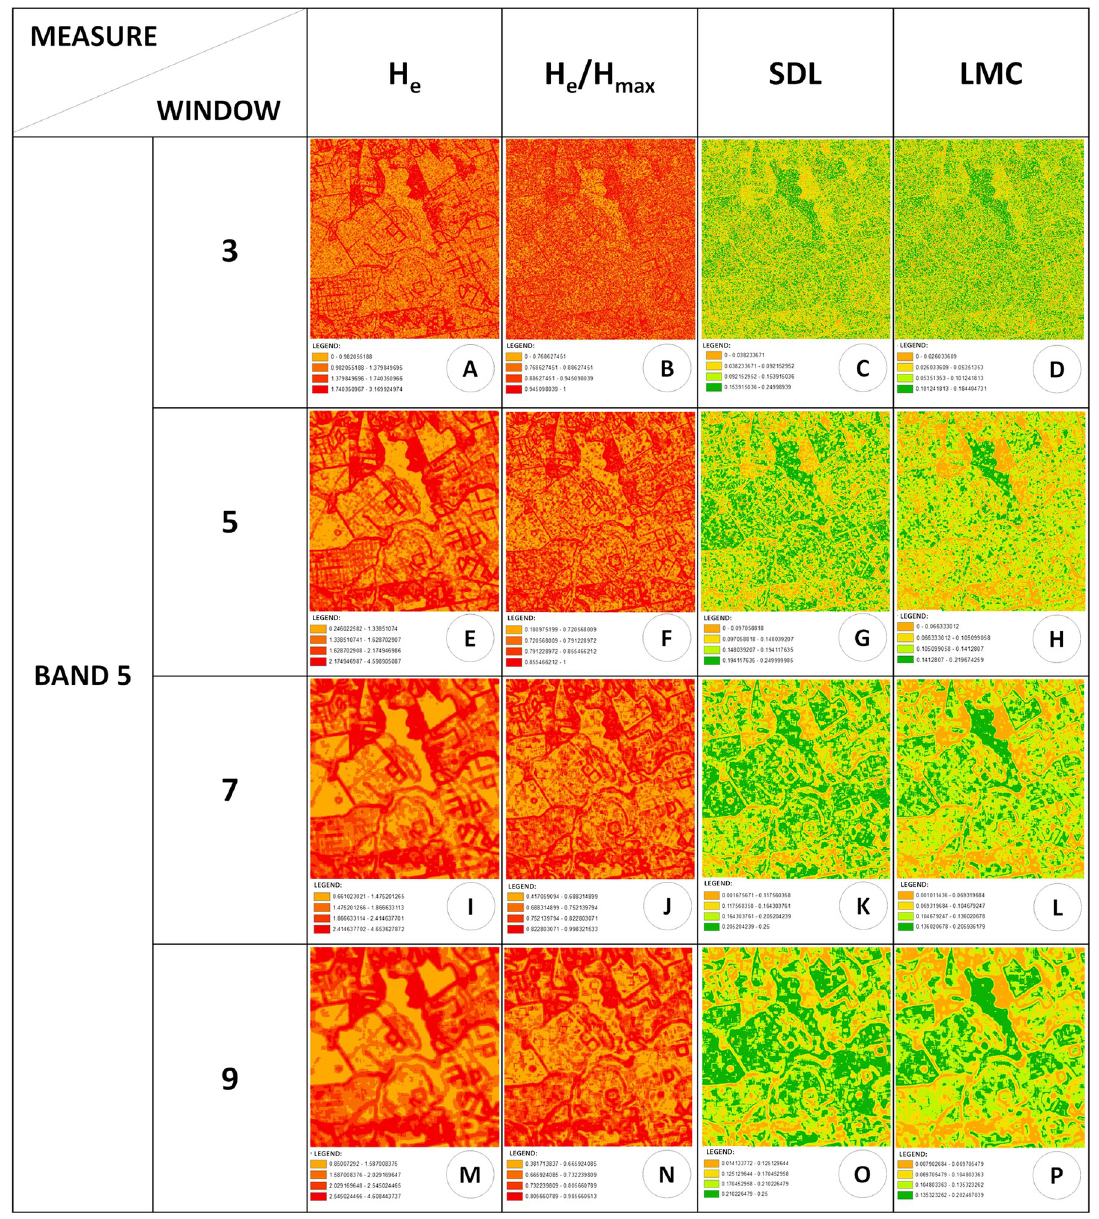
Fig 9. Landscape complexity maps generated by CompPlex Janus for He, He/H max , SDL, and LMC measures applied to different window sizes for band 5, using a CBERS MUX level-4 image of Itirapina Ecological and Experimental Parks and their surroundings (State of Sao Paulo,